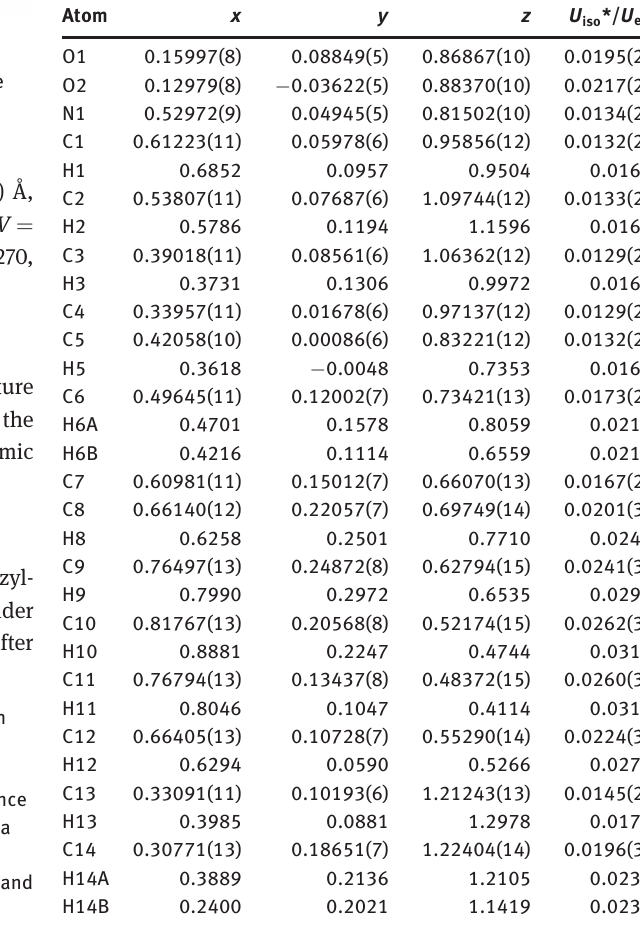
Table 2: Fractional atomic coordinates and isotropic or equivalent isotropic displacement parameters (Å 2